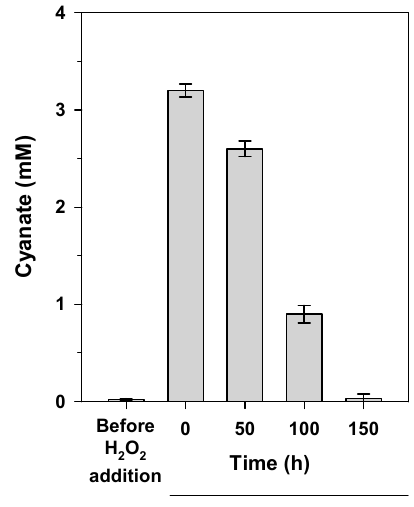
Figure 5. Biodegradation in a batch reactor of jewelry industry wastewater pre-treated with hydrogen peroxide. Before inoculation with P. pseudoalcaligenes CECT5344, a jewelry residue containing metals and 4 mM free cyanide was treated in the reactor with 10 mM hydrogen peroxide to oxidize cyanide to cyanate. The concentration of cyanate was determined before and after the treatment, at the indicated times during the experiment. Error bars show standard deviations of three independent replicates.